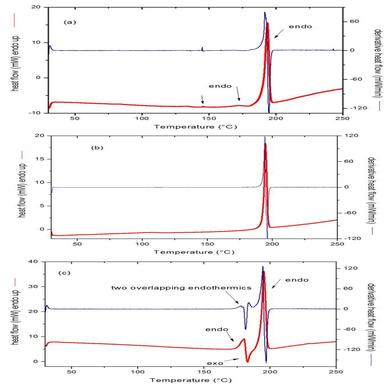
DSC (red) and DDSC (black) curves for OLZ (a) A, (b) B and (c) C samples at a heating rate of 10 °C.min−1 . (For interpretation of the references to color in this figure legend, the reader is referred to the web version of this article.)